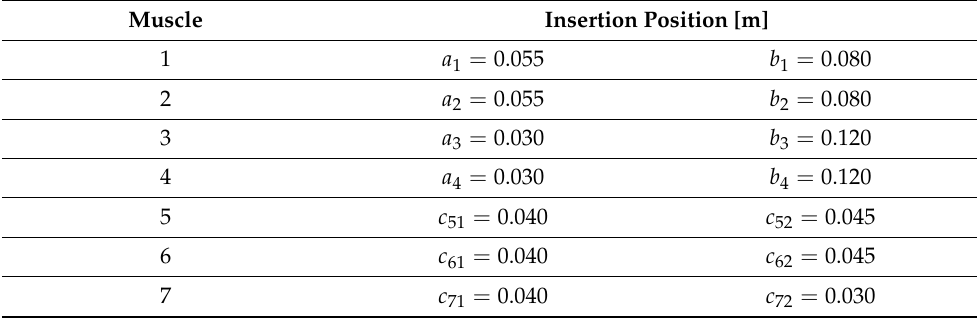
Table 4. Biophysiological parameters of skeletal muscles.